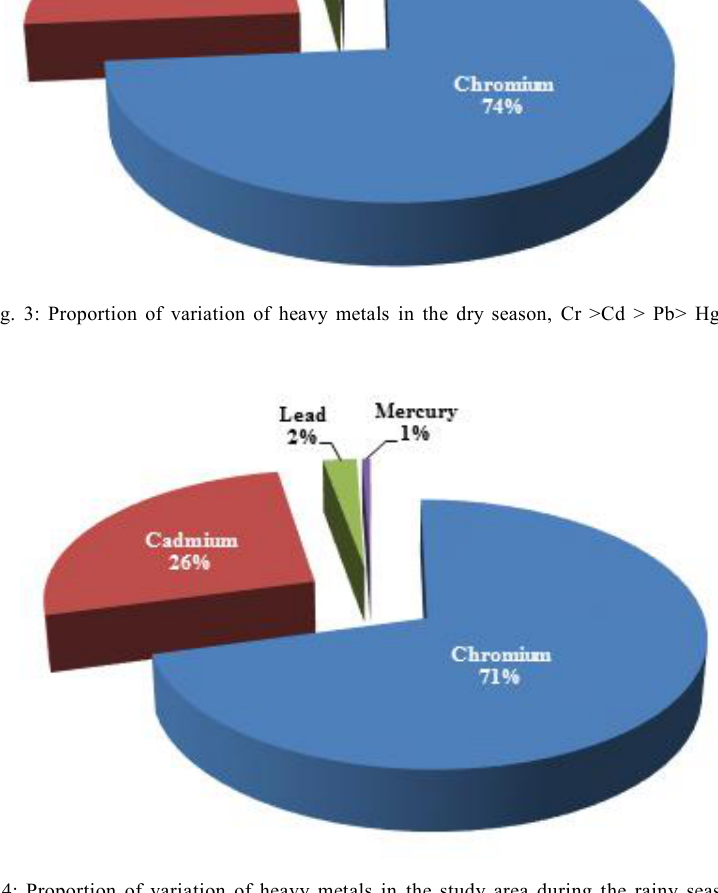
Fig. 4: Proportion of variation of heavy metals in the study area during the rainy season, Cr >Cd > Pb >